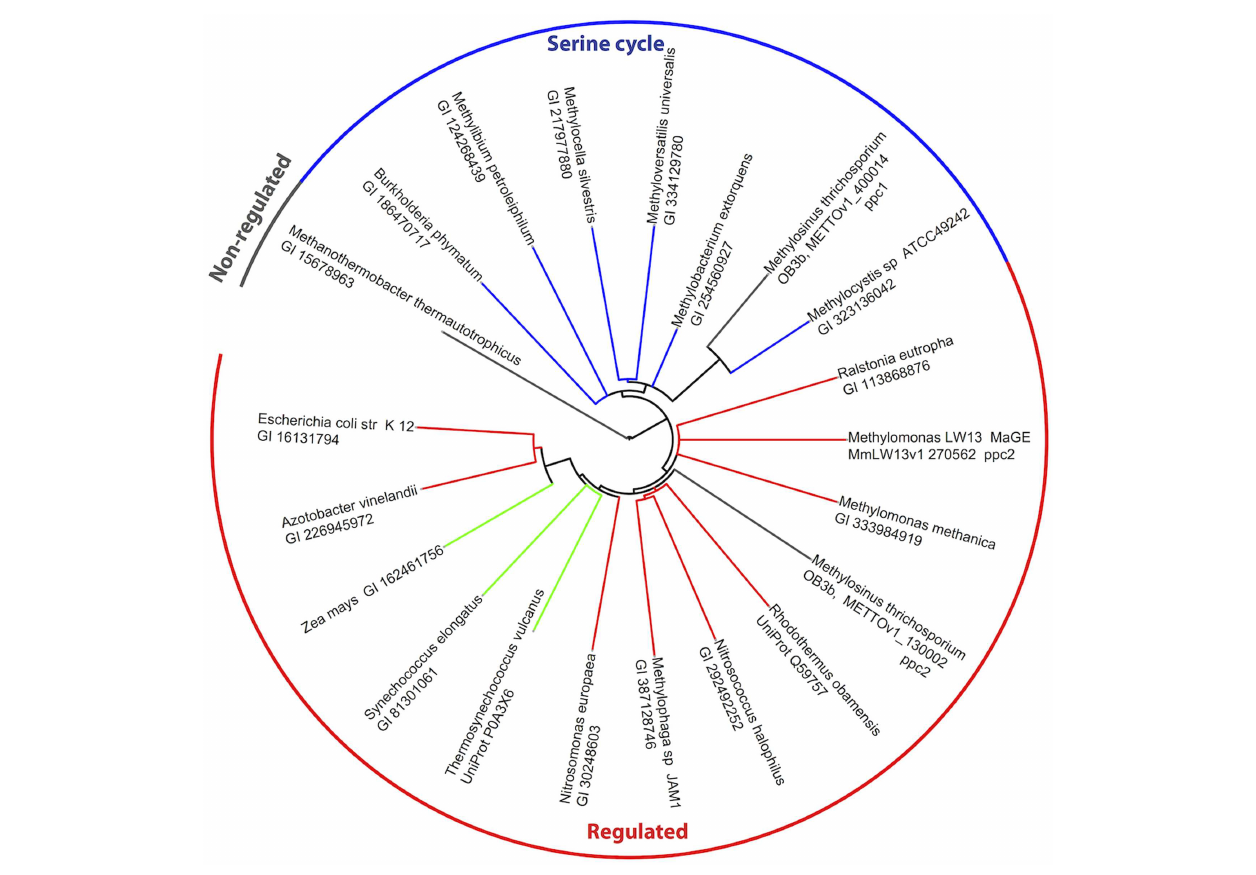
FIGURE 3 | Phylogenetic tree of phosphoenolpyruvate carboxylases. Sequence identifiers follow the source organism label. Sequences were aligned with MUSCLE v3.8.31 (Edgar, 2004) and the tree created with ClustalW2 2.0.12 (Larkin et al., 2007) and rendered with iTOL (Letunic and Bork, 2007).